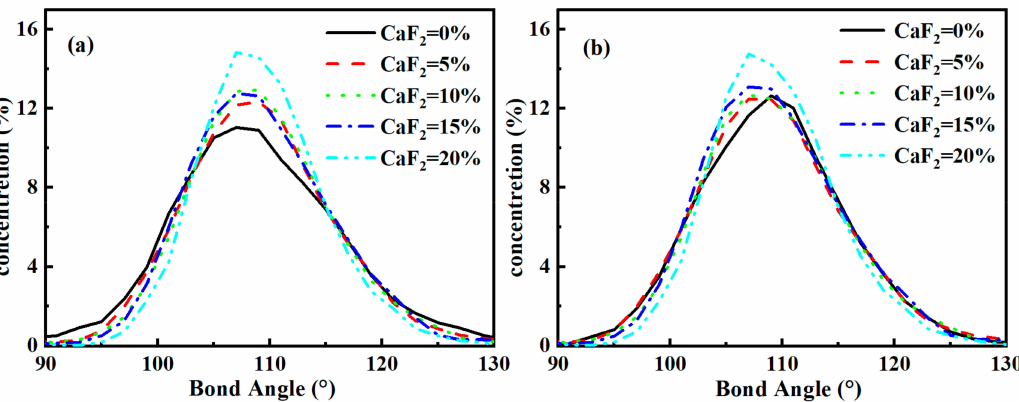
Figure 4. Distribution of bond angles in the system of varying CaF 2 content: ( a ) O-Si-O and ( b )